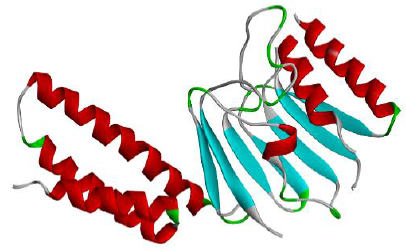
Figure 5. 3D model of the vaccine construct.